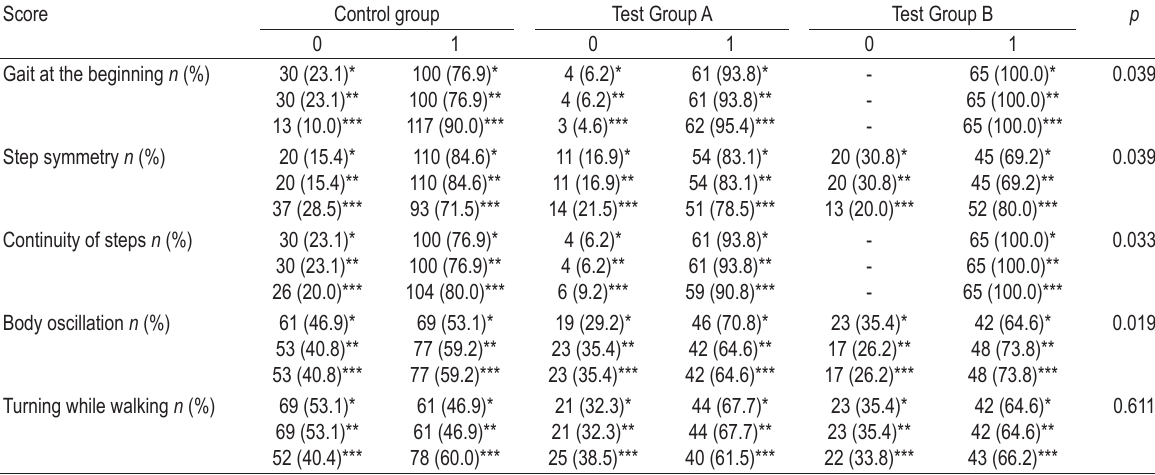
TABLE 3. Comparison of the gait elements values through three measurements in relation to the examined groups ‑ POMA G (Part I)